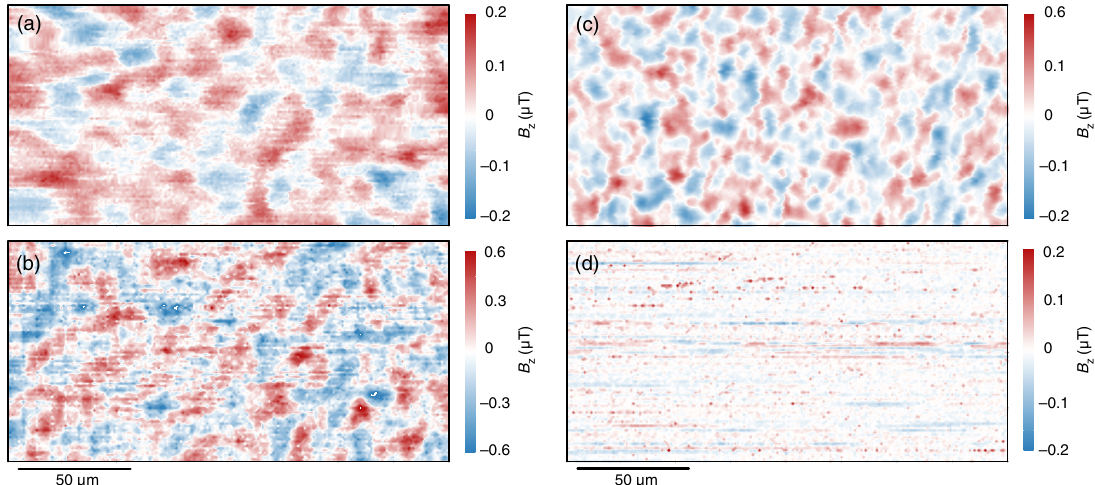
FIG. 12. Scanning SQUID microscopy magnetic signal of samples A (a), B (b), and C (c) measured at H ¼ 0 T and T ¼ 4 . 2 K. A ferromagnetic domain pattern is observed. (d) Measurement of a bare SrTiO 3 sample. No magnetic signal is observed, indicating that the magnetic signal in the superlattice sample is not due to impurities in the SrTiO 3